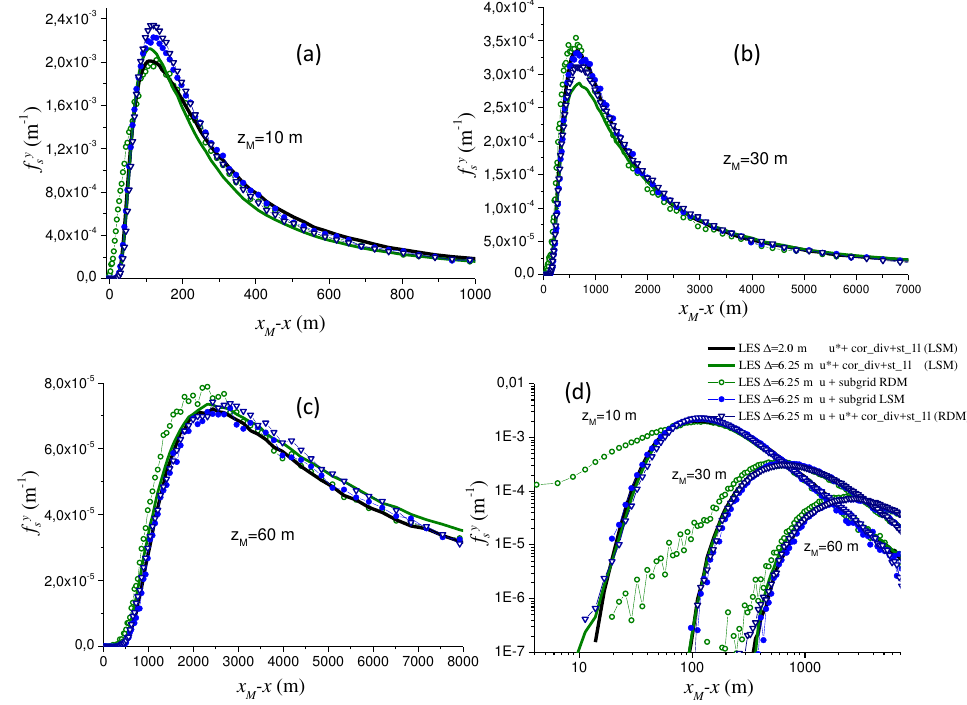
Figure 7. Crosswind-integrated scalar flux footprints f y s , obtained in LES with (cid:49) g = 6.25m using different stochastic Lagrangian subgrid models RDM (Eq. 33) and LSM (Eqs. 28–32). The results obtained with these subgrid models applied within the first computational grid layer in combination with velocity recovering u ∗ = F − 1 u and correction of velocity (Eqs. 34 and 35) are also shown. Black lines are the footprints in LES with (cid:49) g =